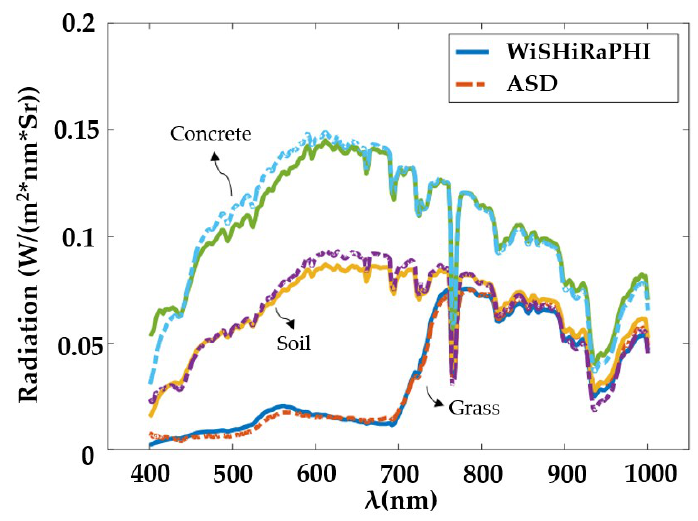
Figure 19. Hyperspectral image of diffuse reflectance targets.